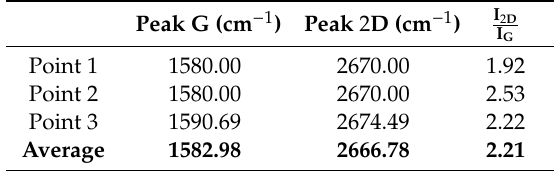
Figure 3. ( a ) Graphene on copper; ( b ) graphene on field-effect transistor (FET); ( c ) Raman spectrum for graphene on copper; ( d ) Raman spectrum for graphene on electrodes and ( e ) Raman spectrum (average value) for graphene on copper and FET. Table 1. Raman spectroscopy data for graphene on copper.